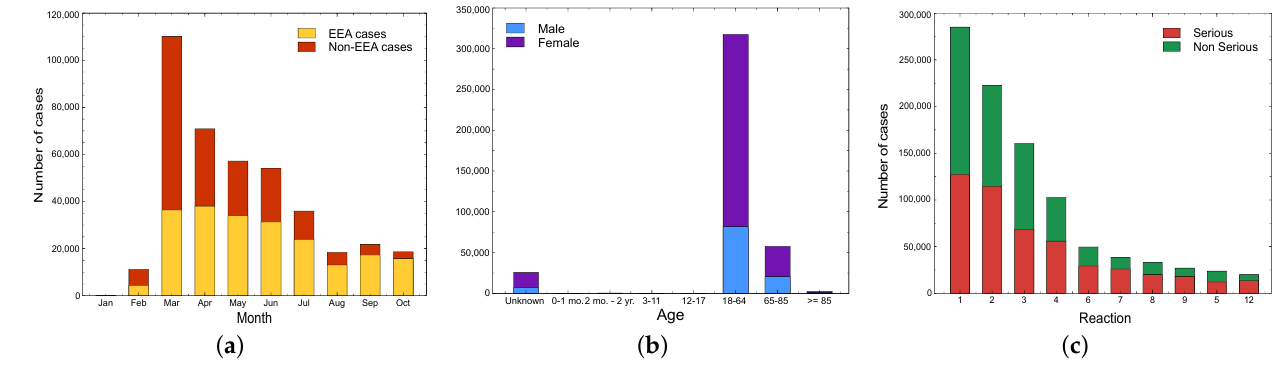
Figure 4. Main results of pharmacovigilance for Vaxzevria vaccine: number of reports received over time ( a ), and their distribution by age group and sex ( b ) and by seriousness ( c ).